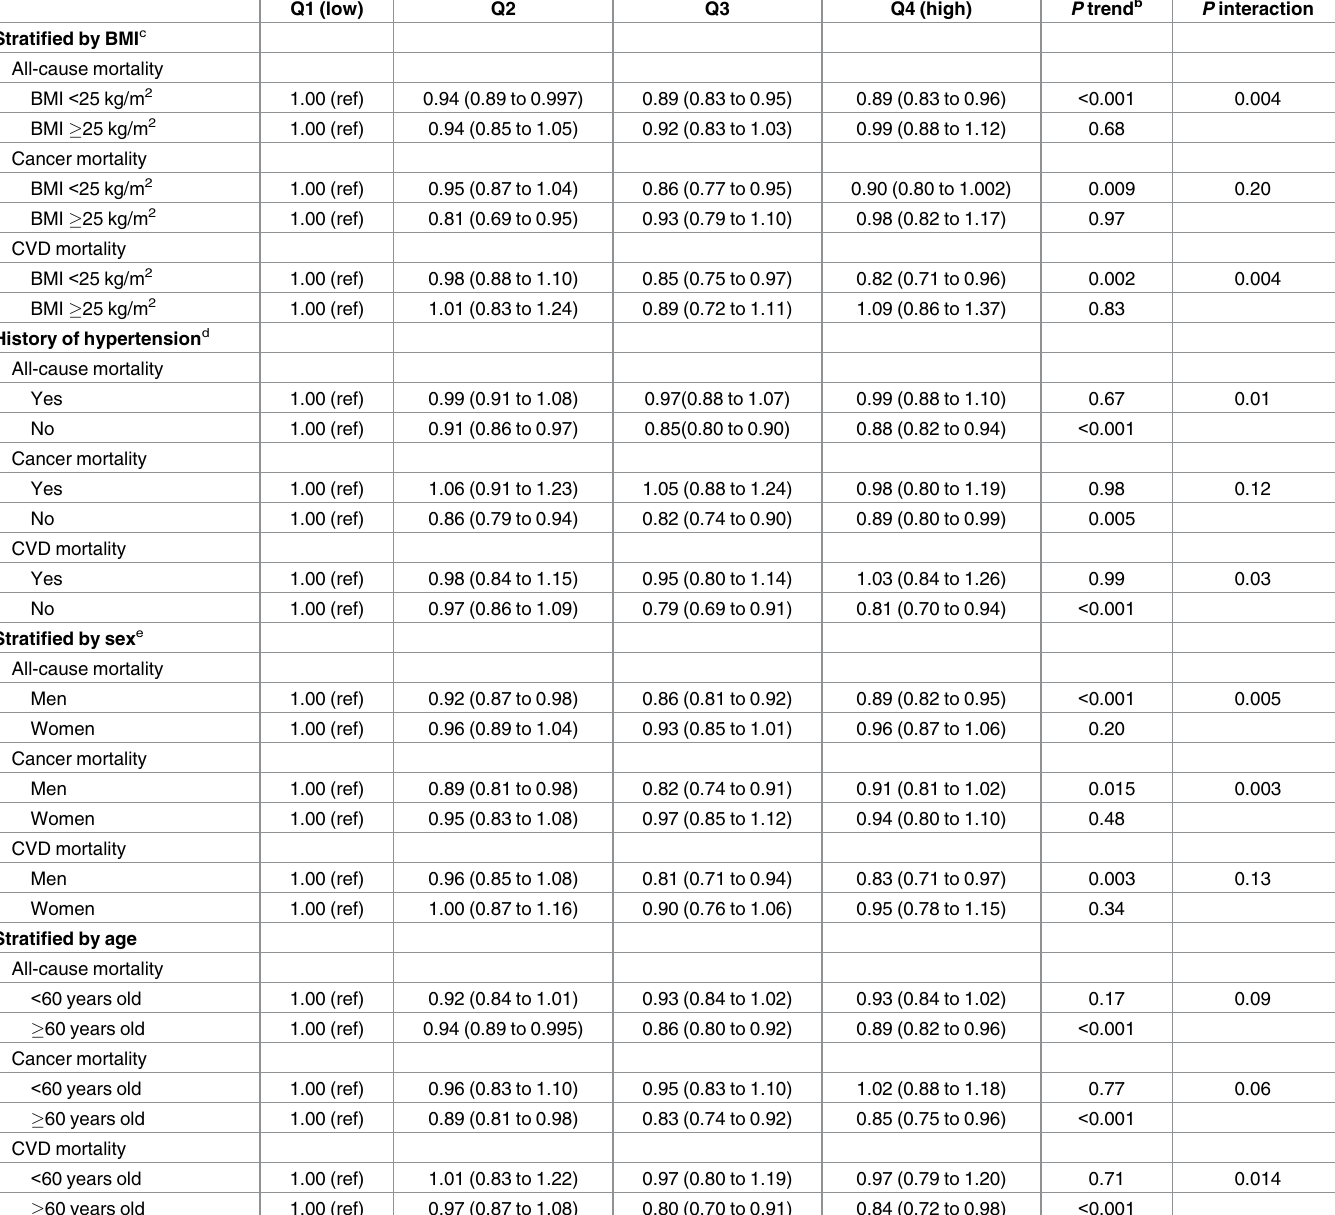
Table 4. Multivariable-adjusted a hazard ratios (95% CI) for all-cause, cancer, and cardiovasculardisease mortality according to quartile (Q) of the Westernized dietary pattern score by body mass index, history of hypertension, sex, and age. Q1 (low) Q2 Q3 Q4 (high) P trend b P interaction